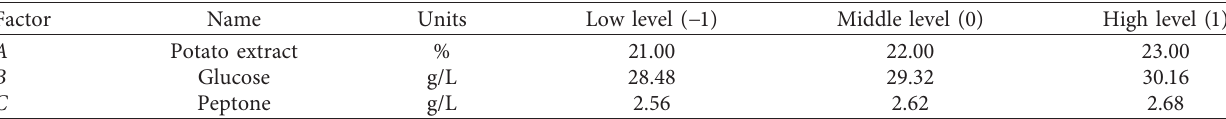
Table 3: Factors and levels for the Box–Behnken